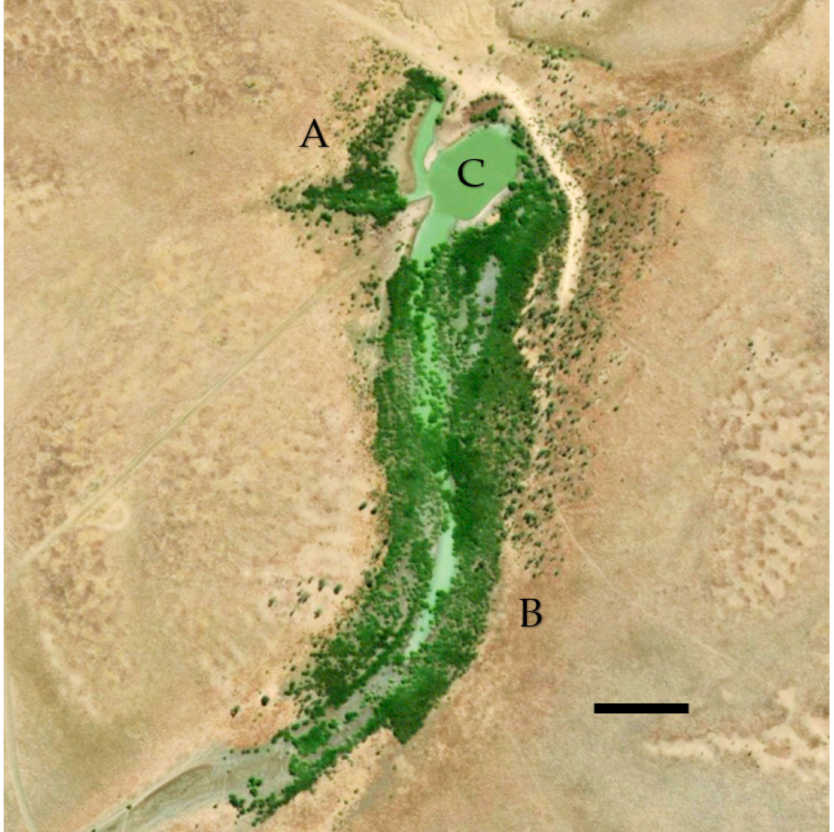
Figure 10. Satellite image of Corporal Dam study site with north infestation ( A ), south infestation ( B ) and dam ( C ). Vegetation almost entirely consisted of Parkinsonia aculeata . Scale bar = 100 m. Image [23] dated